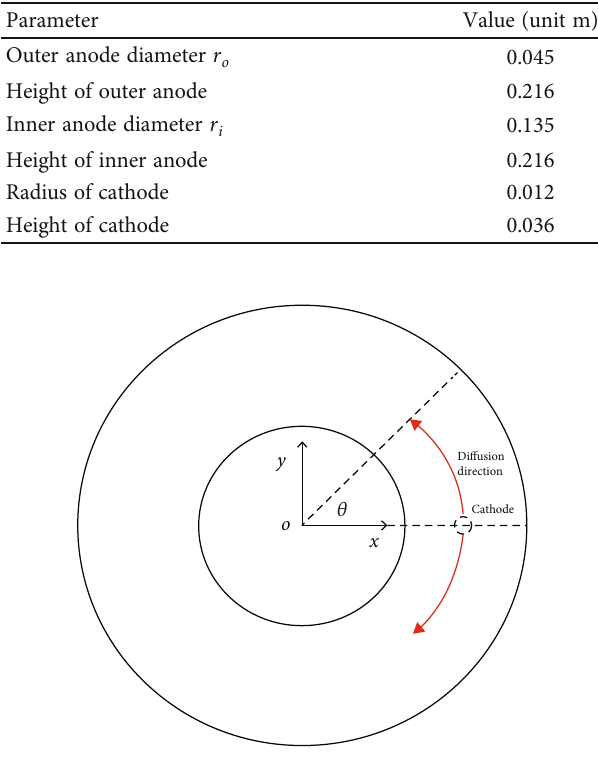
Figure 2: Structure diagram of circumferential di ff